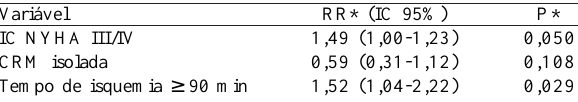
Tabela 4. Análise multivariada da associação das variáveis analisadas com a mortalidade.